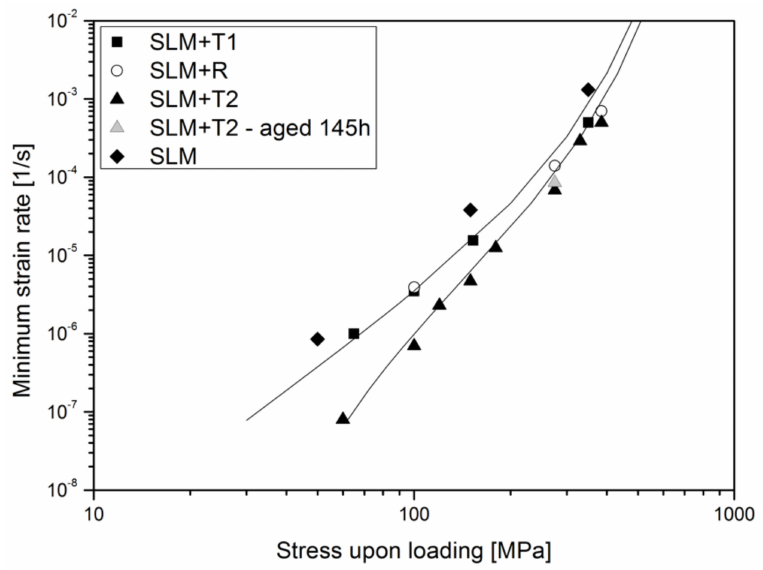
Figure 7. Minimum strain rate dependence on applied stress for T1, T2 and R states; for comparison purposes, also data for a similar alloy tested in as-deposited state are reported (data from [14]). The procedure for curve calculation is illustrated in the Section 4.